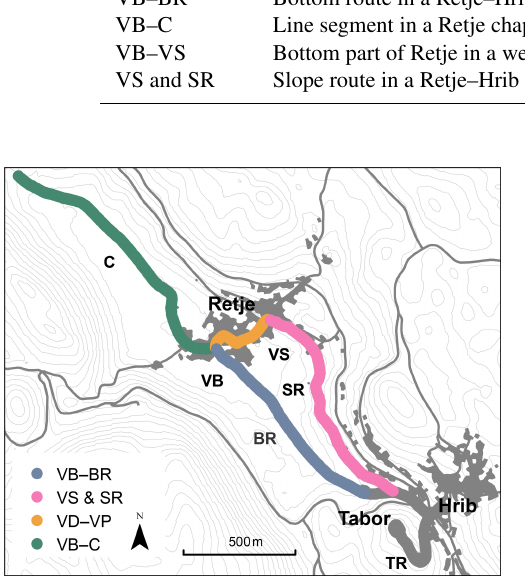
Figure 5. The location codes assigned to the line segments of the fixed route.